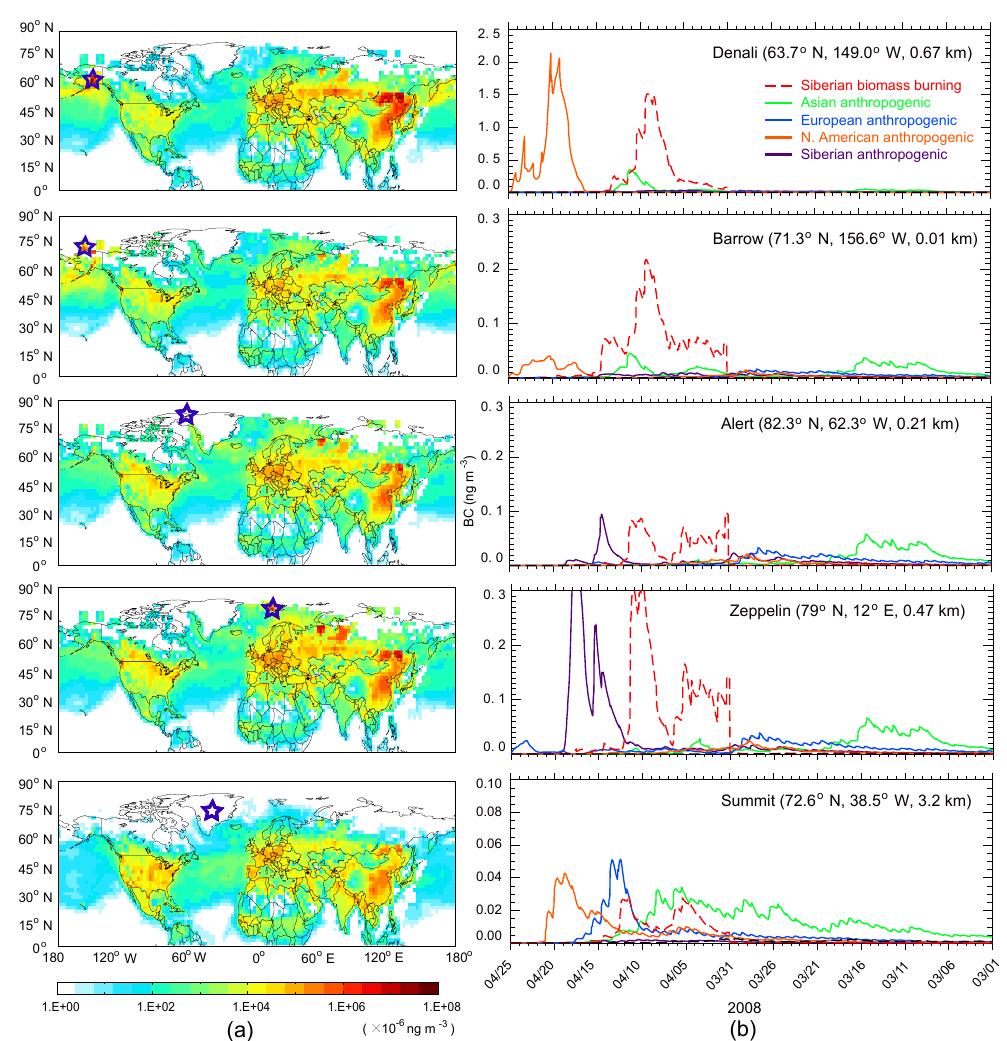
Figure 6. GEOS-Chem-simulated contributions to BC concentrations, averaged over 20–25 April 2008, at (stars, a ) Denali, AL, USA (63.7 ◦ N, 149.0 ◦ W; 0.66kma.s.l.), Barrow, AL, USA (71.3 ◦ N, 156.6 ◦ W; 10ma.s.l.), Alert, Canada (82.3 ◦ N, 62.3 ◦ W; 210ma.s.l.), Zep- pelin, Norway (79 ◦ N, 12 ◦ E; 470ma.s.l.), and Summit, Greenland (72.6 ◦ N, 38.5 ◦ W; 3.22kma.s.l.), from Northern Hemisphere emissions as computed from adjoint simulations (see Sect. 3.2 for details): (a) cumulative contributions from 1 March to 25 April and (b) time- dependent contributions from Siberian biomass burning (red dashed line), Asian anthropogenic (solid green line), European anthropogenic (solid blue), North American anthropogenic (solid orange), and Siberian anthropogenic sources (solid purple). Source regions are as defined in Fig.